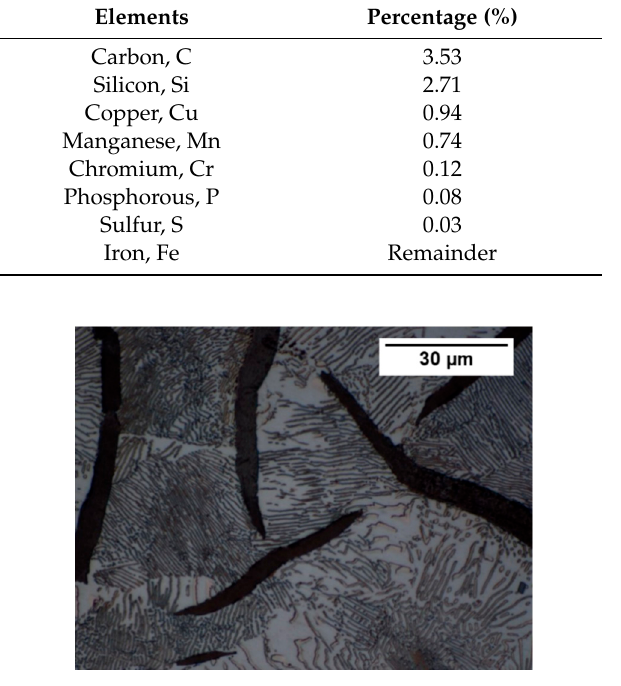
Figure 1. Microstructure of the As-Received Gray Cast Iron (Graphite Flake + Pearlite).